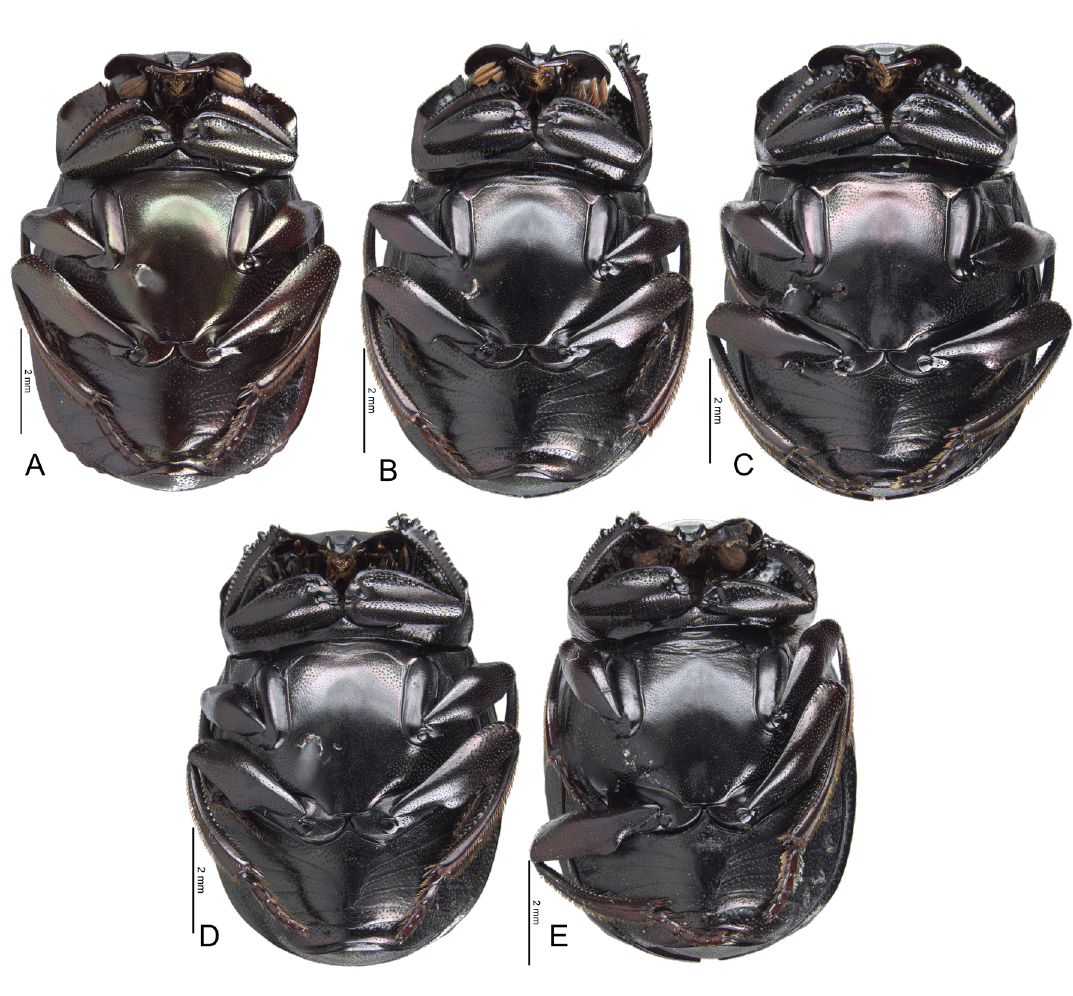
Fig. 6. Ventral view of members of the gilli species group. A . Holotype of Deltochilum gilli González- Alvarado & Vaz-de-Mello, 2021, CNCI 379888. B . Holotype of D. jocelynae sp. nov., CNCI 379889. C . Holotype of D . nonstriatum sp. nov., CMNEN WSD00041746. D . Holotype of D . quasistriatum sp. nov., CMNEN WSD00041744. E . Holotype of D . tenuistriatum sp. nov., CMNEN